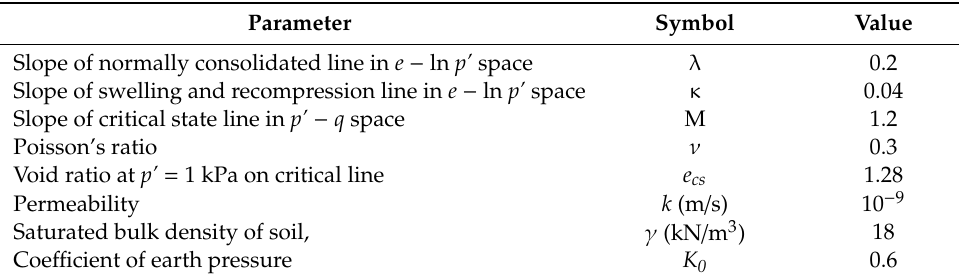
Table 2. Parameters of the Modified Cam Clay (MCC) model.